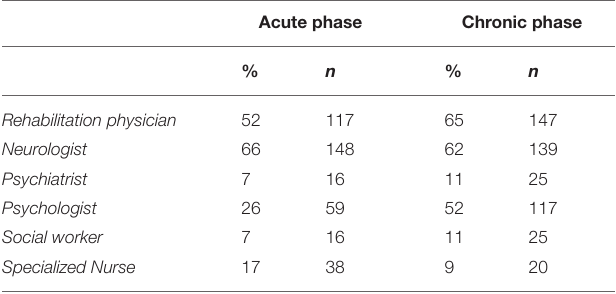
TABLE 5 | Care providers for patients in the acute and chronic phase post-injury. Acute phase Chronic